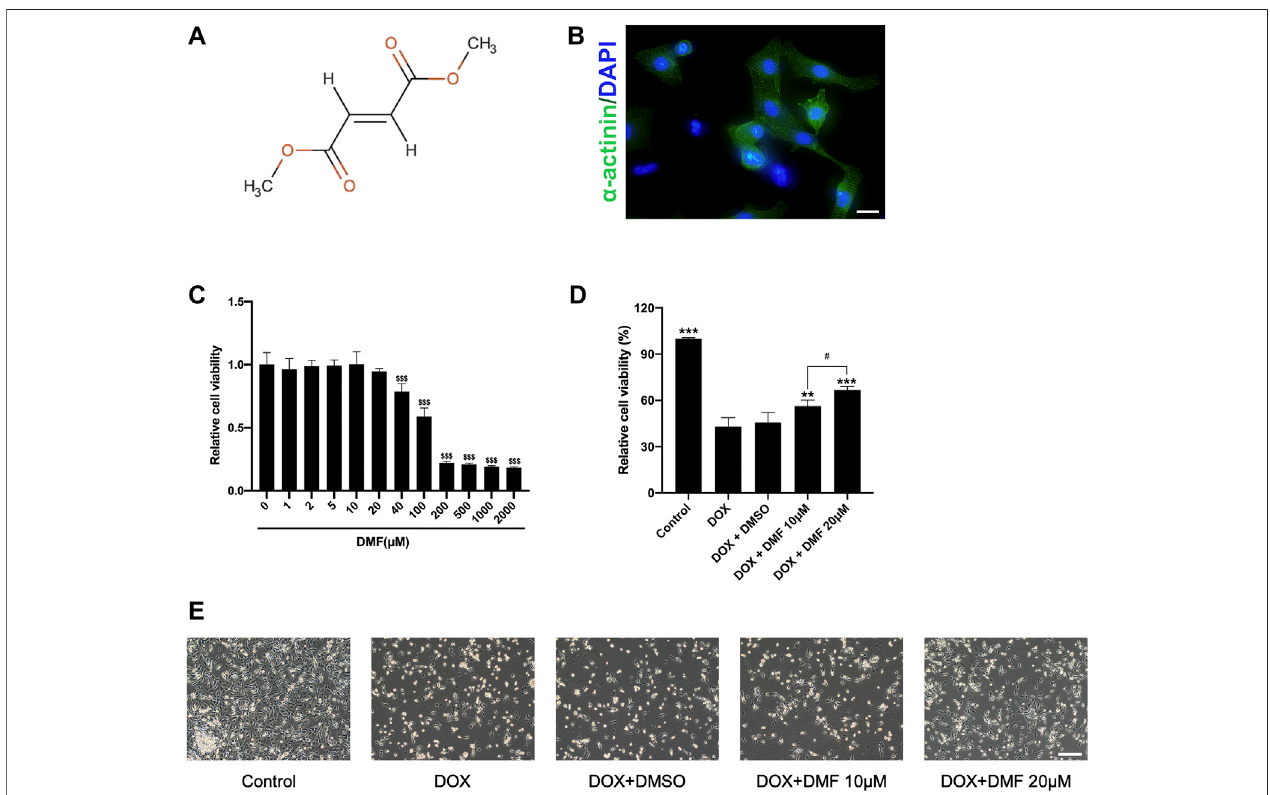
FIGURE1| DMFalleviatesNRCMsdamageagainstDOX. (A) Chemicalstructureofdimethylfumarate. (B) Immuno fl uorescenceof α -actinininNRCMs(scalebar= 20 μ m). (C) Cell viability ofNRCMs with different concentrations ofDMF ( n =4). (D) Changes in cell viability ( n =4). (E) Changes in cellular morphology ( n = 4, scale bar = 50 μ m).Datawerepresentedasthemean±SD. $$$ p < 0.001,comparedwiththecontrol group,*** p < 0.001,compared withtheDOXgroup. # p < 0.05,comparedwith DOX + DMF 10 μ M